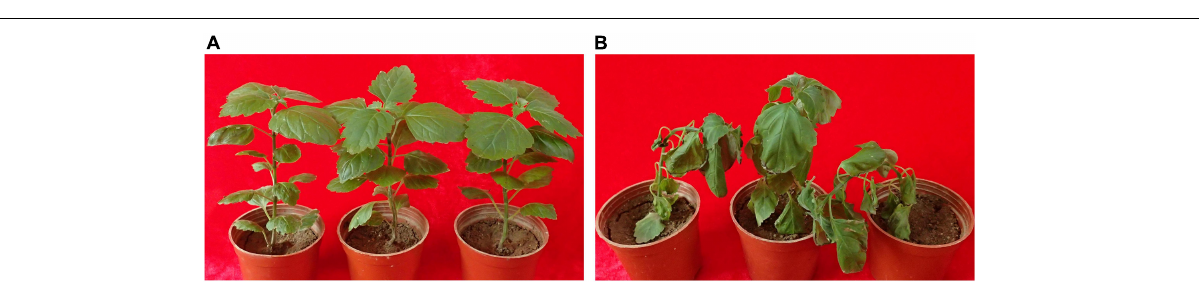
Frontiers in Microbiology |